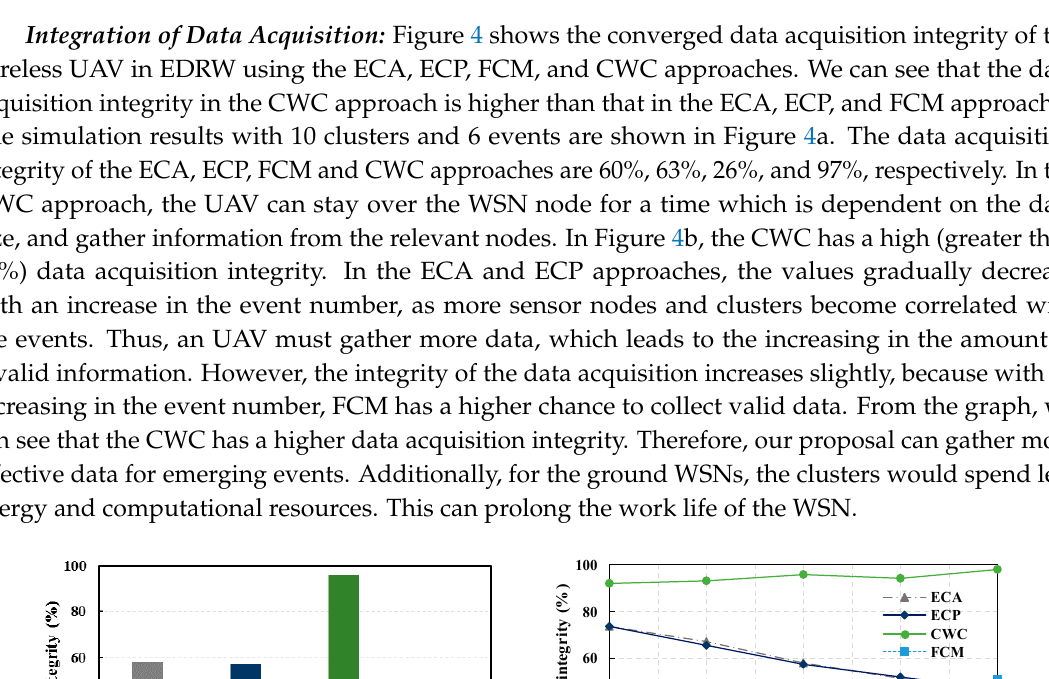
Figure 3. Comparison of the flight times and distances for UAV-sink. ( a ) Flight Time and Distances in different event number; ( b ) Flight Time and Distances in different cluster number.